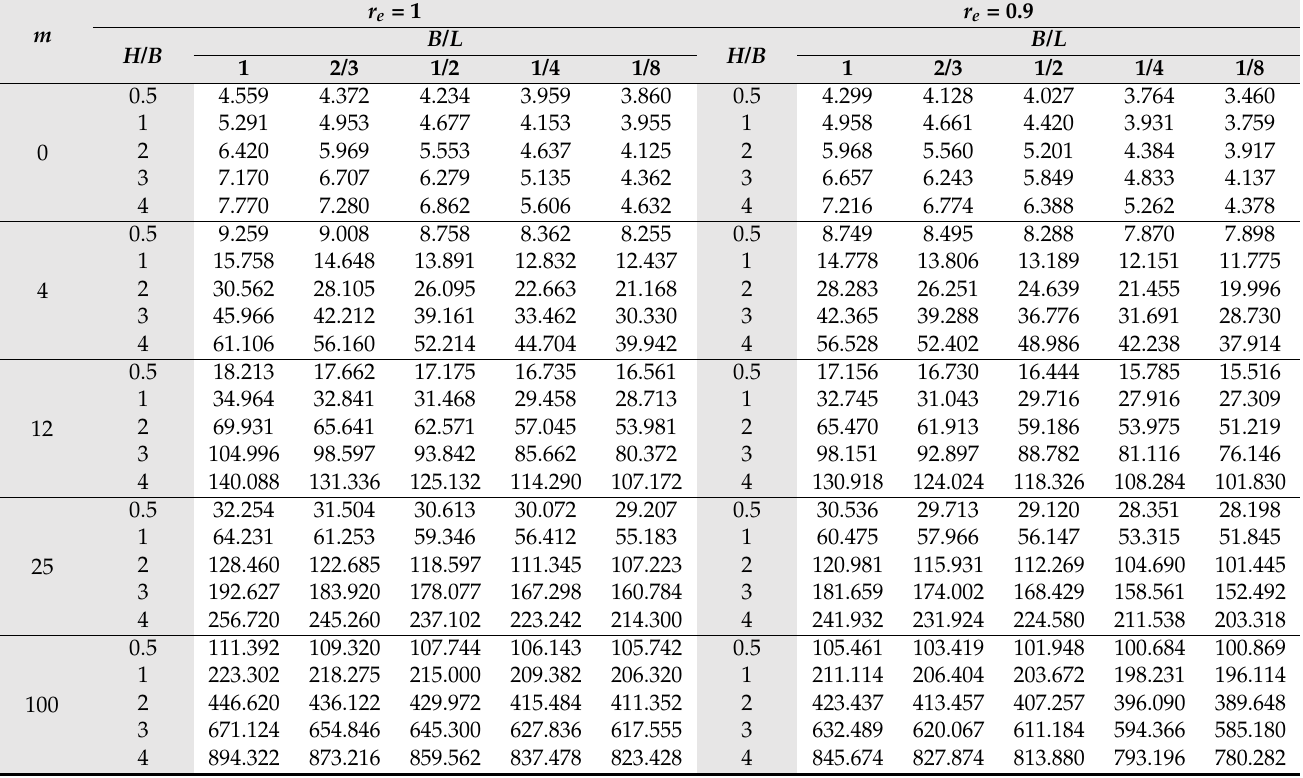
Table 1. Stability numbers, N ( r e = 1.0 and 0.9).